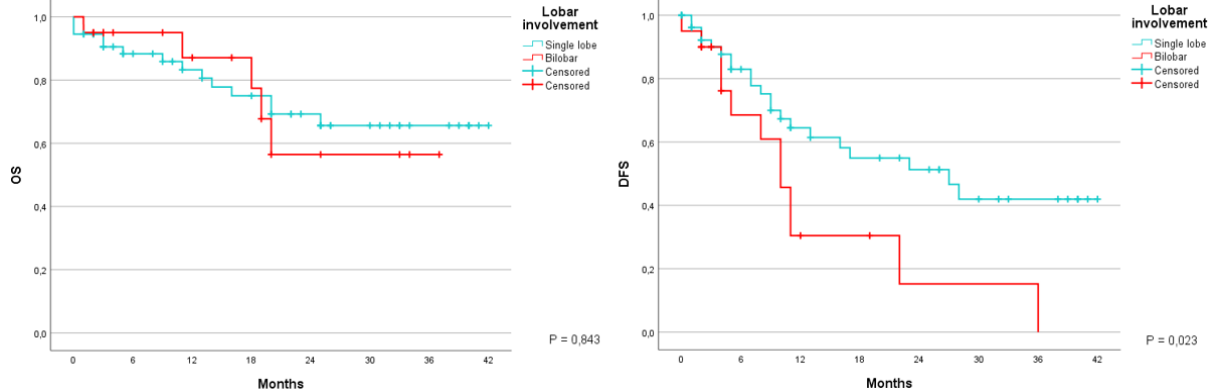
Figure 9. Kaplan-Meier Curve for OS and DFS in patients who underwent liver resection for CRLM stratified according to lobar involvement. OS: Overall Survival; DFS: Disease Free Survival; CRLM: Colorectal liver metastasis.